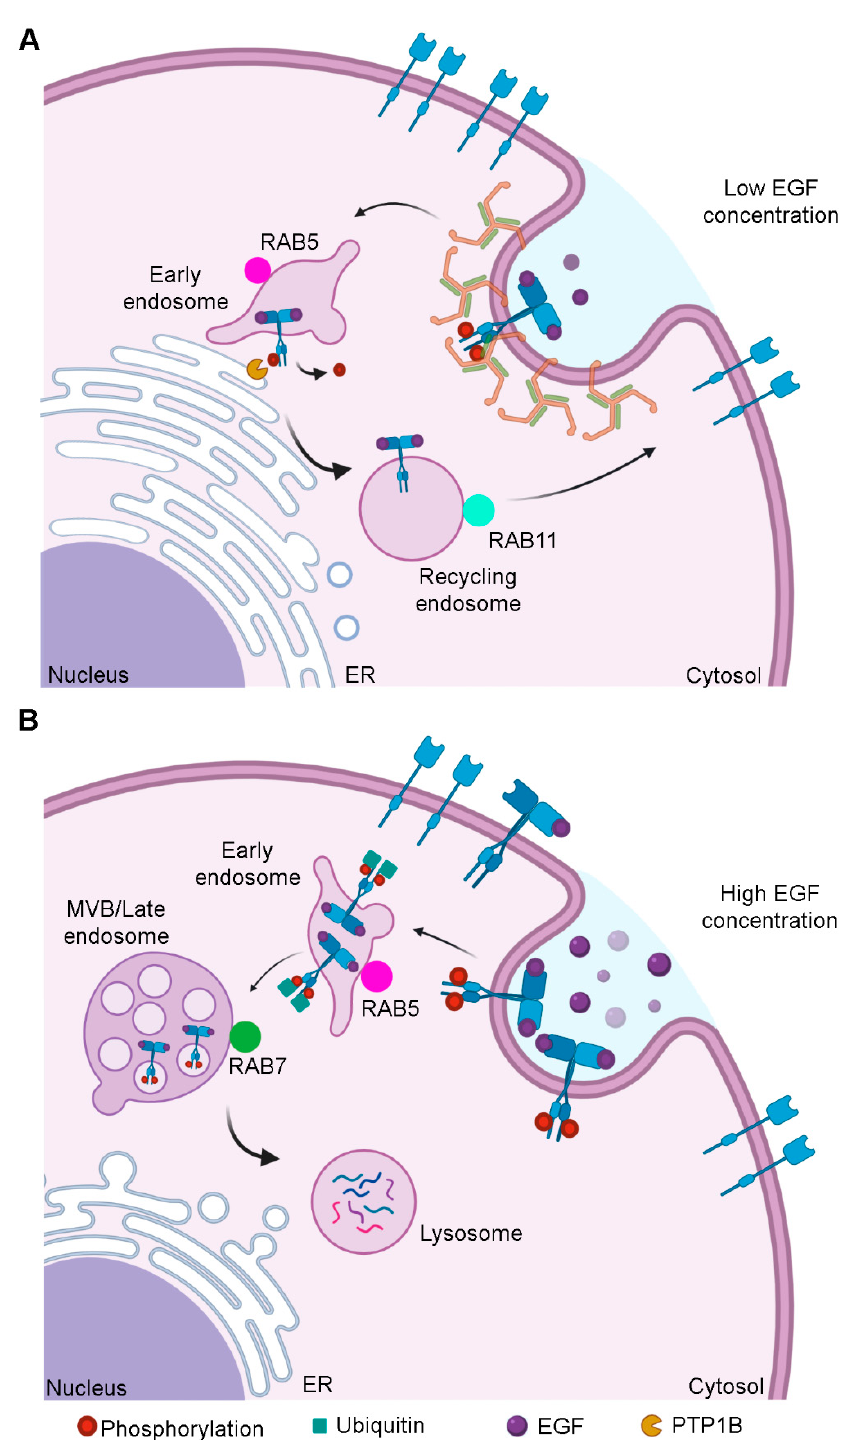
Figure 2. Intracellular fate of epidermal growth factor receptor (EGFR) after its activation. ( A ) When EGF is poorly concentrated, EGFR undergoes a low activation and it is subjected to clathrin-mediate endocytosis. The receptor reaches the early endosomes and tyrosine-protein phosphatase non-receptor 1 (PTP1B), which resides in the ER, dephosphorylates EGFR at the contact sites between ER and early endosomes. Then, EGFR is recycled back to the plasma membrane in RAB11-positive vesicles. ( B ) When EGF concentration is high, EGFR is more activated, and it is internalized through clathrin-independent endocytosis. After ubiquitination EGFR, reaches multivesicular bodies (MVBs) before being degraded into lysosomes.